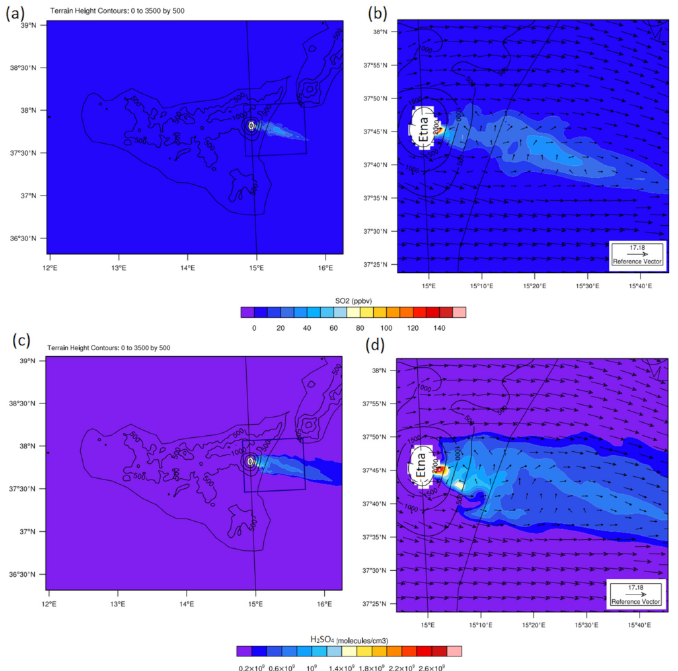
Figure 3. Simulated SO 2 ( a , b ) and H 2 SO 4 ( c , d ) concentrations on 15 July 2016 (11:00 UTC) over the 2100 m horizontal cross-section in the third domain ( left panels) and downwind zoomed area ( right panels) in simulation S2. Black contours show terrain height (in meters). The arrows on right panels show wind properties: speed (m s − 1 ) and